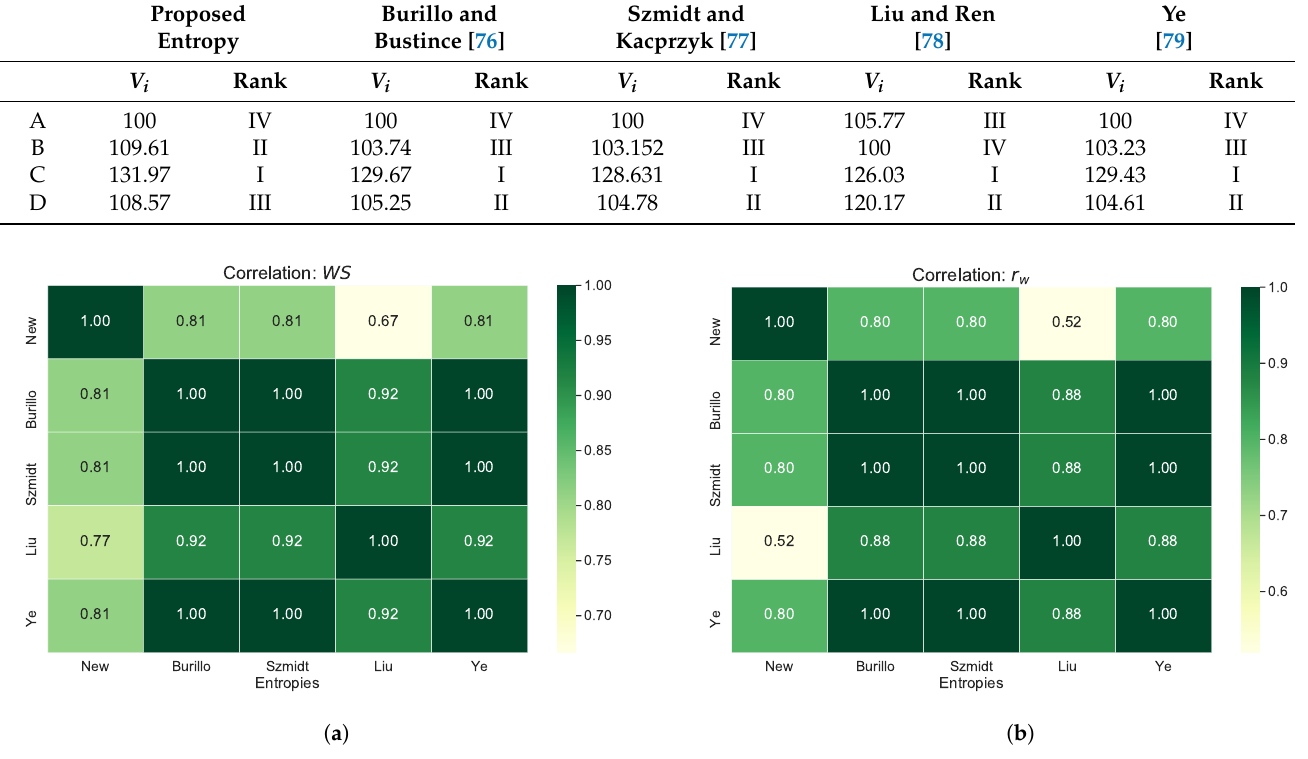
Figure 2. WS and r w correlation heat maps for different entropy methods. ( a ) Comparison of rankings of different entropies using ranking similarity coefficient. ( b ) Comparison of rankings of different entropies using Spearman correlation